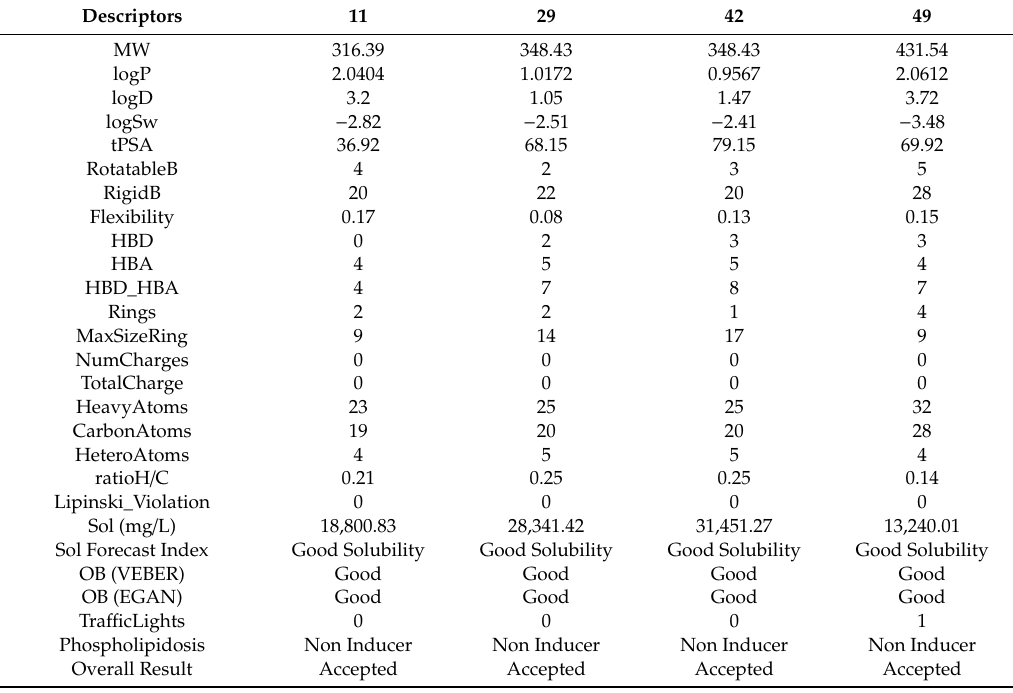
Table A3. Absorption, distribution, metabolism, and excretion–toxicity (ADMET) properties of best-docked compounds within the active site of COX-2.